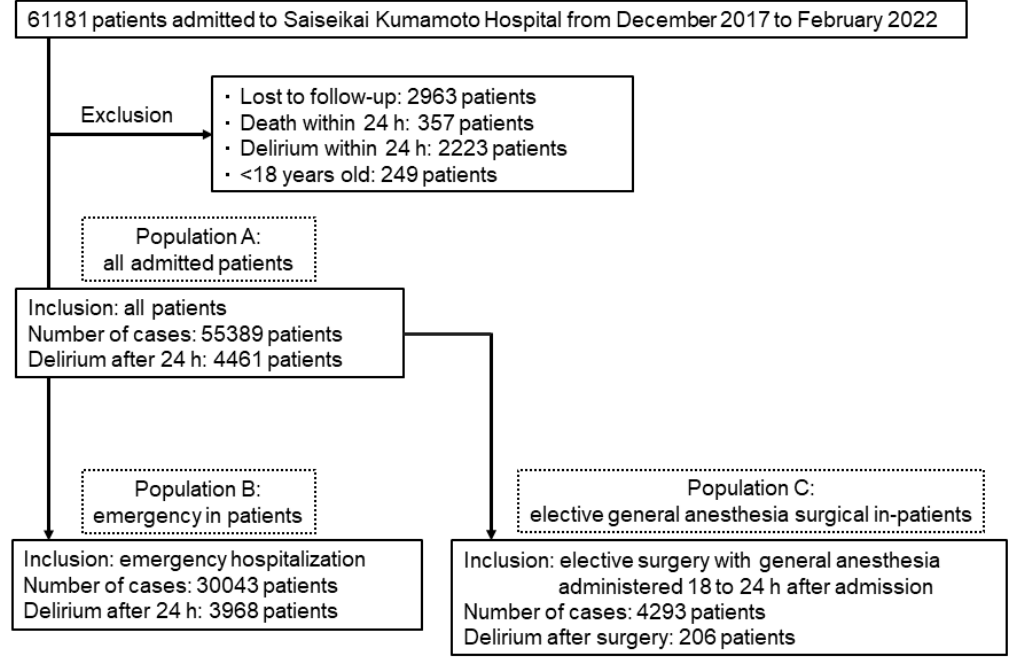
Figure 1. Flow chart of the patients.